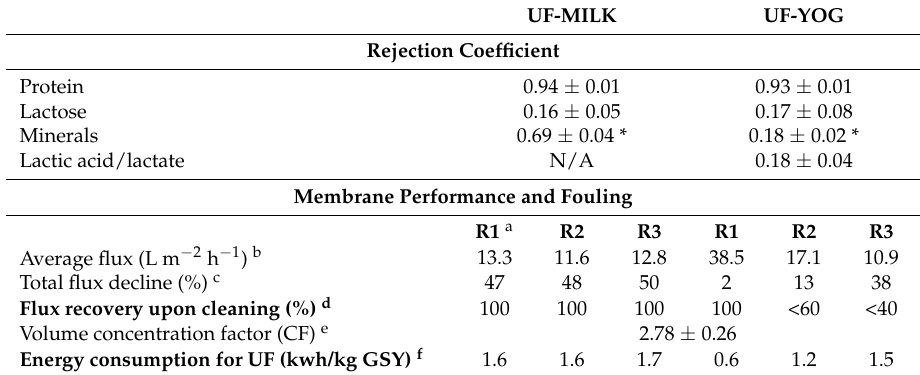
Table 1. Comparative performance of 30 kDa spiral-wound membrane on UF of milk and